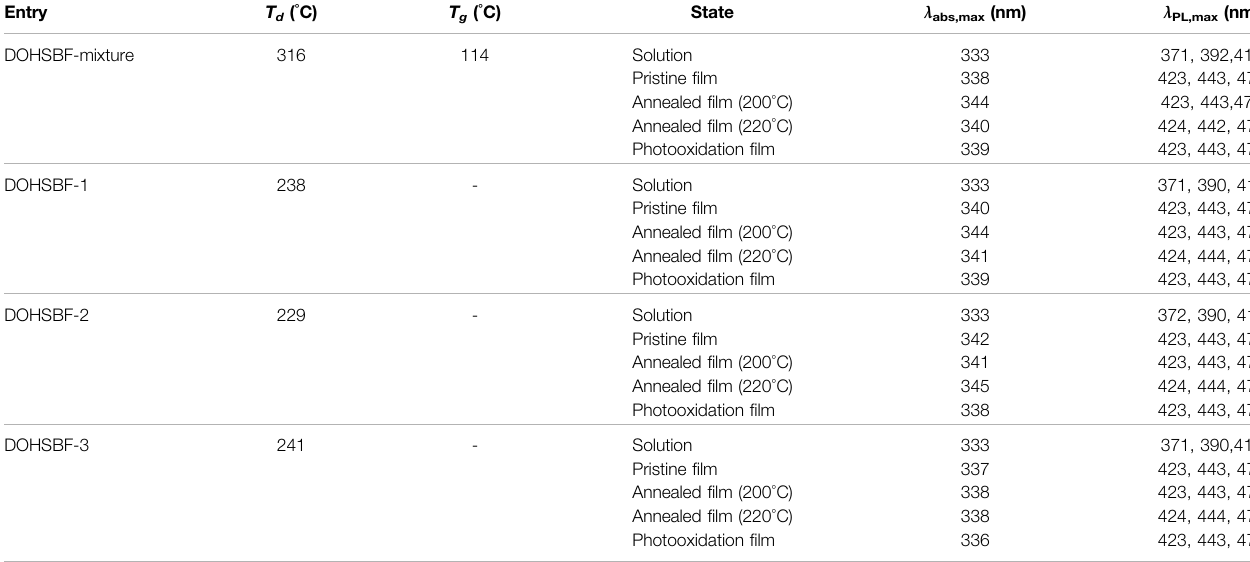
TABLE 1 | Photophysical properties of the isomers at various